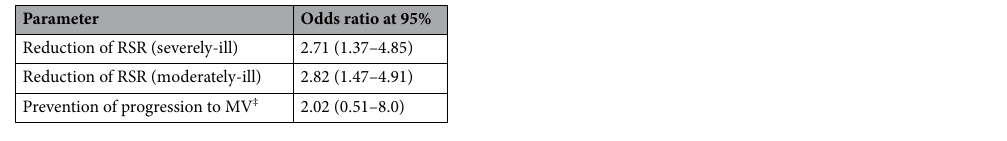
Table 1. Respiratory support requirements. CI confidence interval, RSR respiratory support requirements, MV mechanical